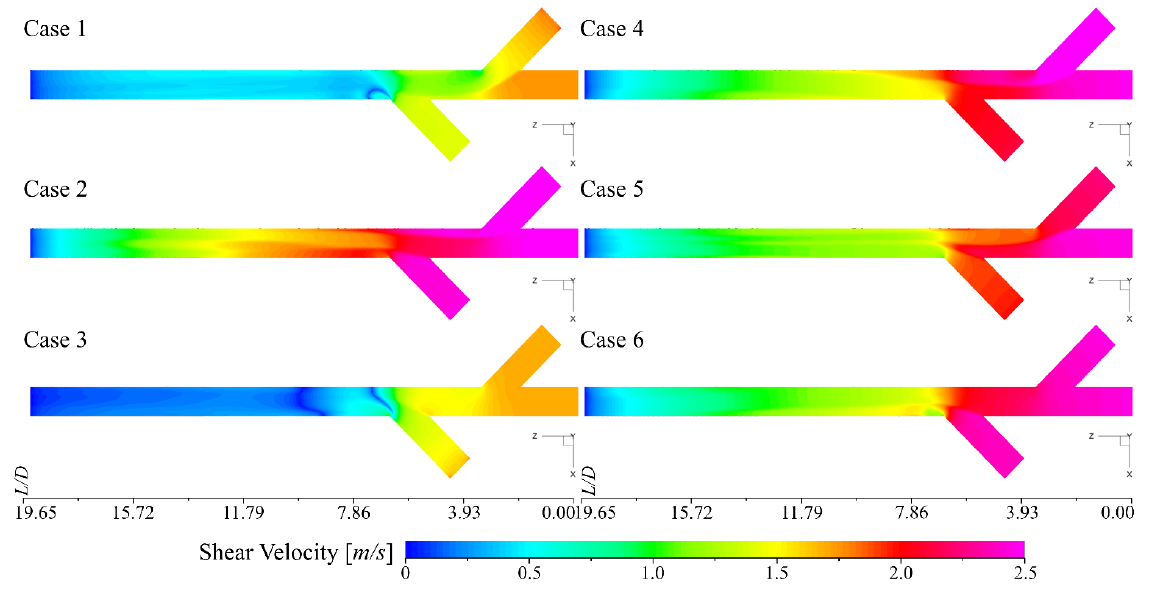
Figure 6. Shear velocity contours of the different injection scenarios.